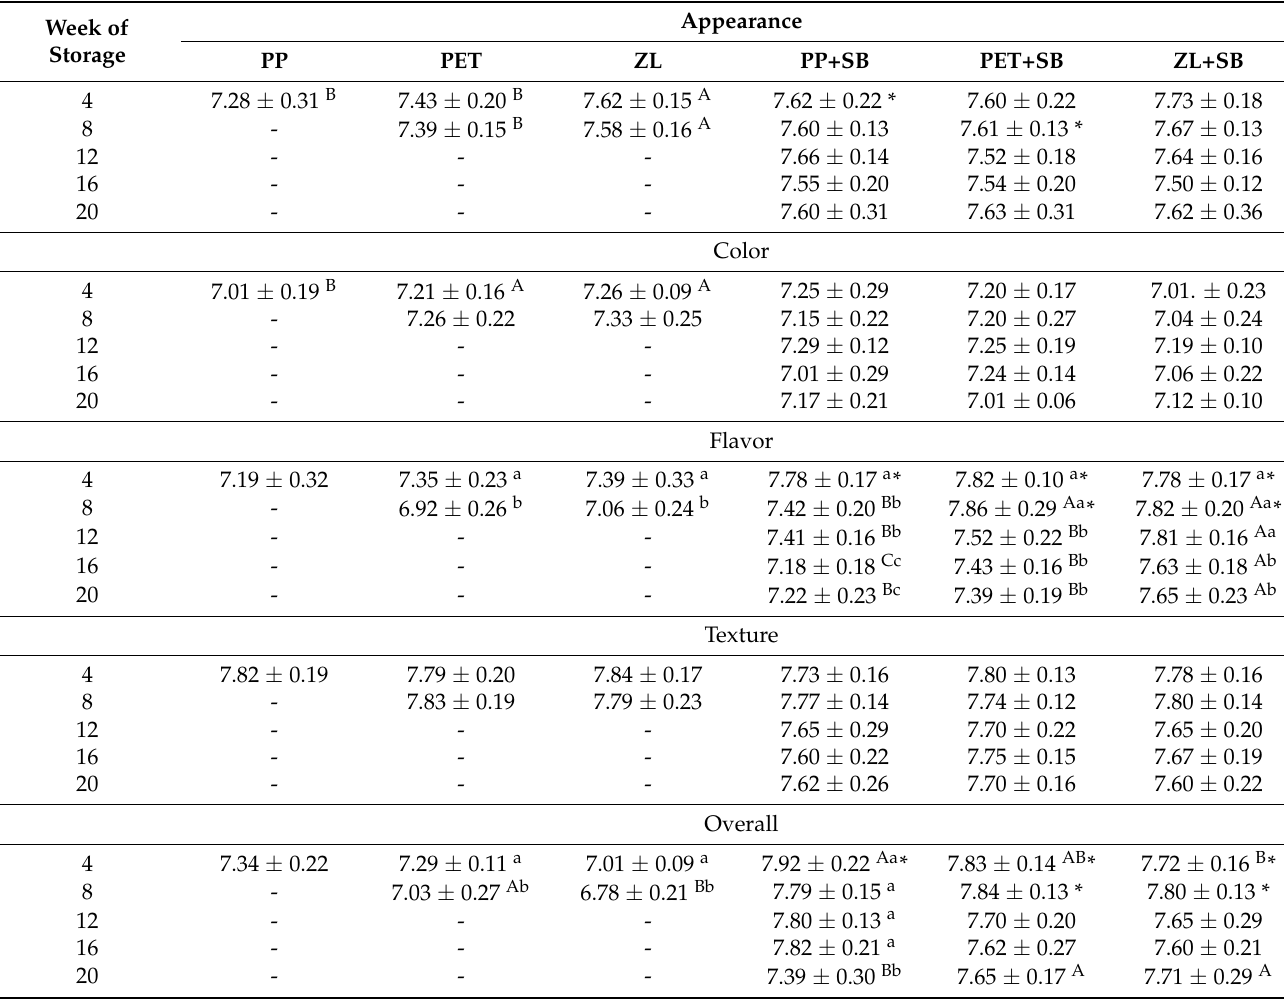
Table 5. Sensory evaluation of dried chili fish paste during storage in various packaging at room temperature. Week of